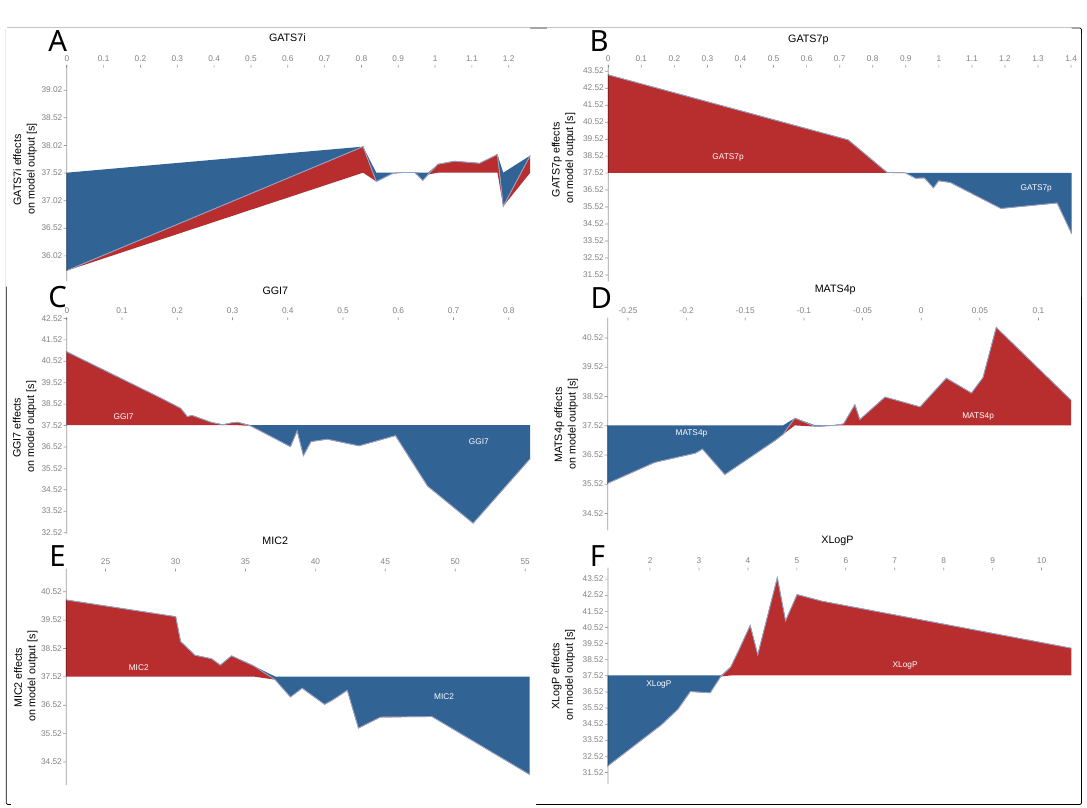
Figure 6. SHAP plots representing effects of various manufacturing parameters on the disintegration time: punch die of tablet press [mm] ( A ), thickness [mm] ( B ), hardness [N] ( C ), amount of API [%] ( D ).